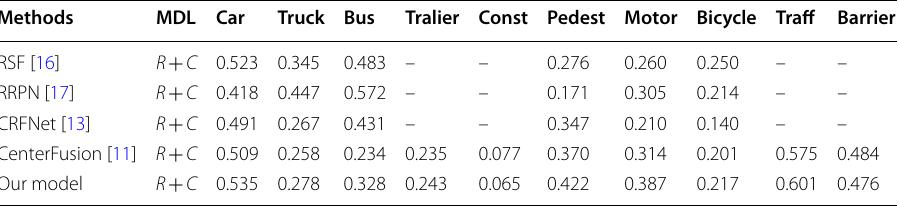
Table 3 Results of millimeter-wave radar and image fusion methods for object classification detection in the nuScenes test